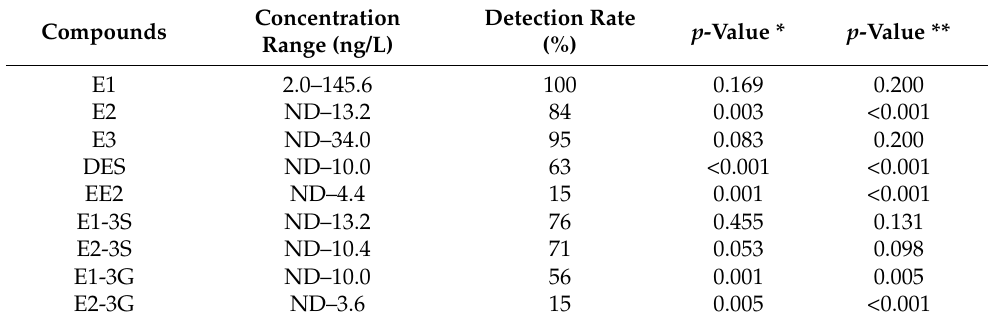
Table 2. Estrogen concentrations ranges, detection rates and p values of the normality test.